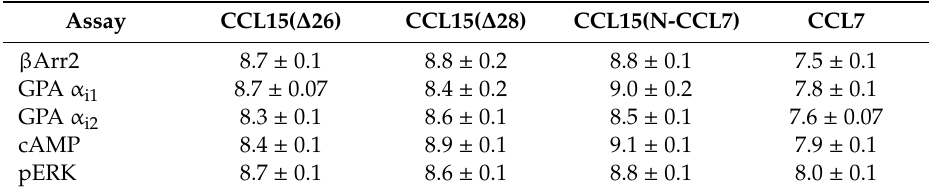
Table A2. Transduction coe ffi cients Log( τ / K A ) for chemokine N-terminal variants 1